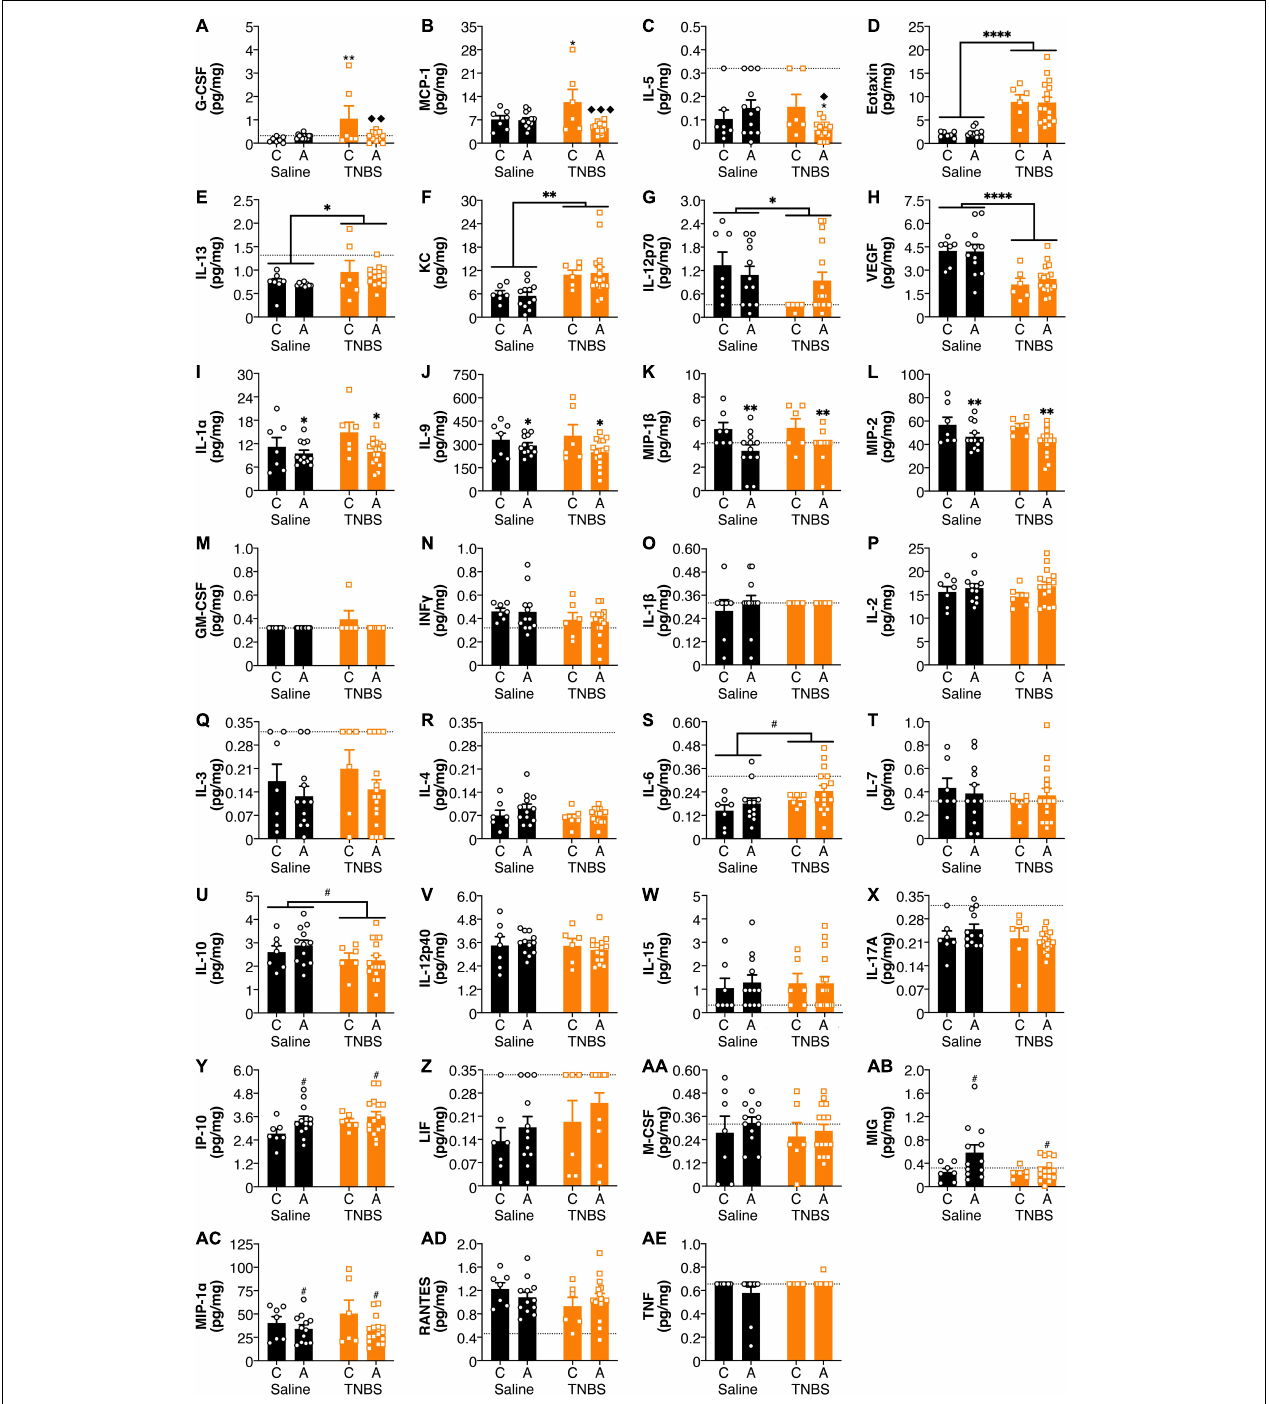
FIGURE 3 | FAAH SNP altered colitis-induced changes in amygdala cytokines and chemokines. Having an A allele mitigated colitis induced increases in (A) G-CSF, (B) MCP-1, and (C) IL-5. Colitis increased levels (D) Eotaxin, (E) IL-13, and (F) KC and reduced levels of (G) IL-12p70 and (H) VEGF. Possessing an A allele led to lower levels of (I) IL-1 α , (J) IL-9, (K) MIP-1 β , and (L) MIP-2. There were no significant changes in (M) GM-CSF, (N) INF γ , (O) IL-1 β , (P) IL-2, (Q) IL-3, (R) IL-4, (S) IL-6, (T) IL-7, (U) IL-10, (V) IL-12p40, (W) IL-15, (X) IL-17A, (Y) IP-10, (Z) LIF, (AA) M-CSF, (AB) MIG, (AC) MIP-1 α , (AD) RANTES, and (AE) TNF. n = 5–16/group. * p < 0.05, ** p < 0.01, saline vs. TNBS of same genotype. (cid:7) p < 0.05, (cid:7)(cid:7) p < 0.01, (cid:7)(cid:7)(cid:7) p < 0.001, C vs. A of same condition (saline or TNBS). # p < 0.1, ∗ p < 0.05, ∗∗ p < 0.01, ∗∗∗∗ p < 0.0001 main effect of colitis (lines) or genotype (symbols above bars). Saline = left pair, black bars with circles. TNBS = right pair, orange bars with squares. In each pair, the left bar is the C allele group (CC genotype) and the right bar is the A allele group (AC/AA genotypes). Dotted lines indicate minimal detection threshold for the analyte and was included in graphs where values were below threshold or the threshold value was used.